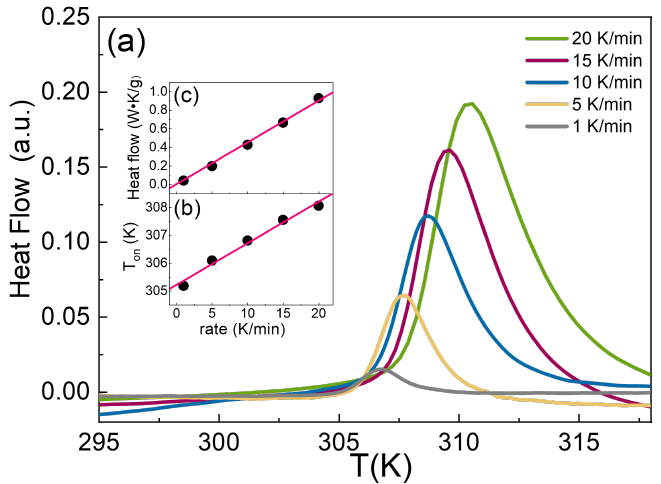
Figure 3. ( a ) DSC thermograms of IPN microgel at C PAAc = 2.7%, C w = 2.8%, pH 5.5 and different heating rates. ( b ) Onset temperature and ( c ) Normalized heat flow as a function of heating rate. Lines are linear fits to data.